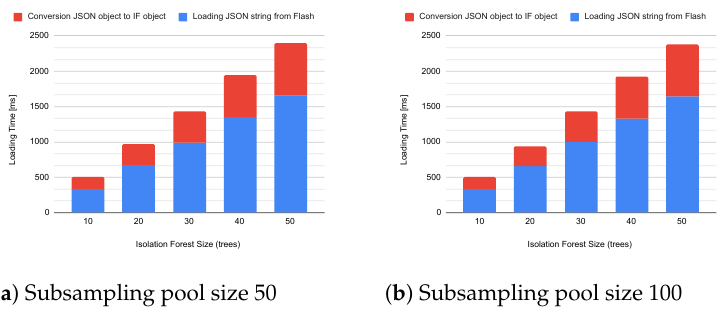
Figure 7. Model loading time with subsampling pool of 50 ( a ) and 100 instances ( b